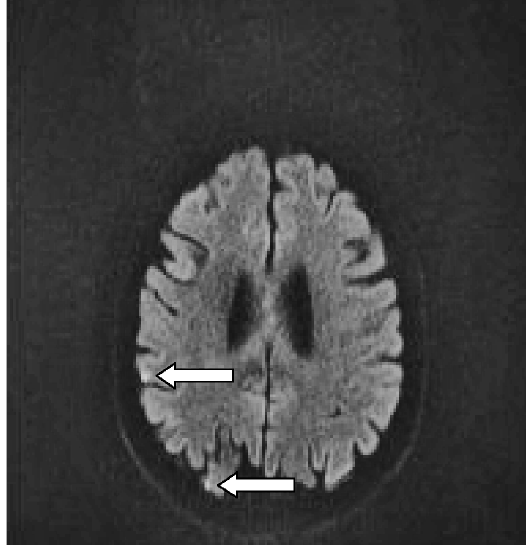
Clinically silent lesions after carotid interven- tions. One day after angioplasty and stent- ing for a high-grade, symptomatic internal carotid stenosis, DWI revealed two punctu- ate lesions (arrows), not visible on the pre- stenting DW-image. The patients had nei- ther transient nor per- sistent clinical symp- toms nor